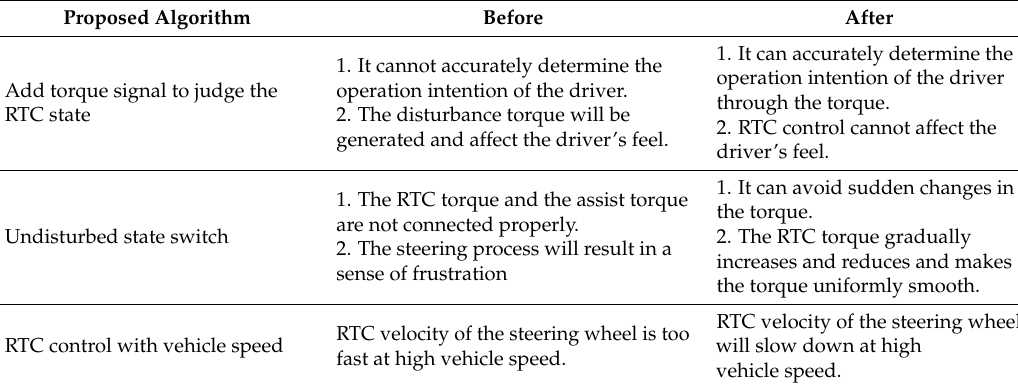
Table 1. Advantages of the algorithm.